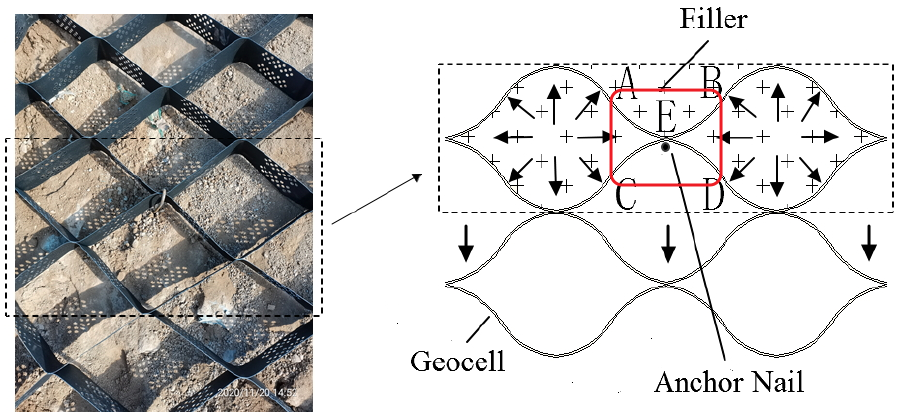
Figure 4. Schematic diagram of local stress.